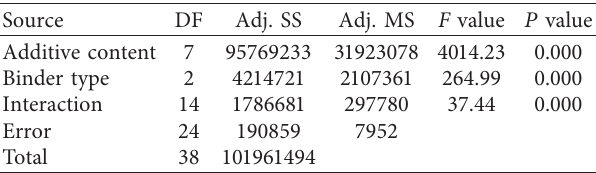
Table 12: Two-way ANOVA: Mr versus additive and binder type. Source DF Adj.